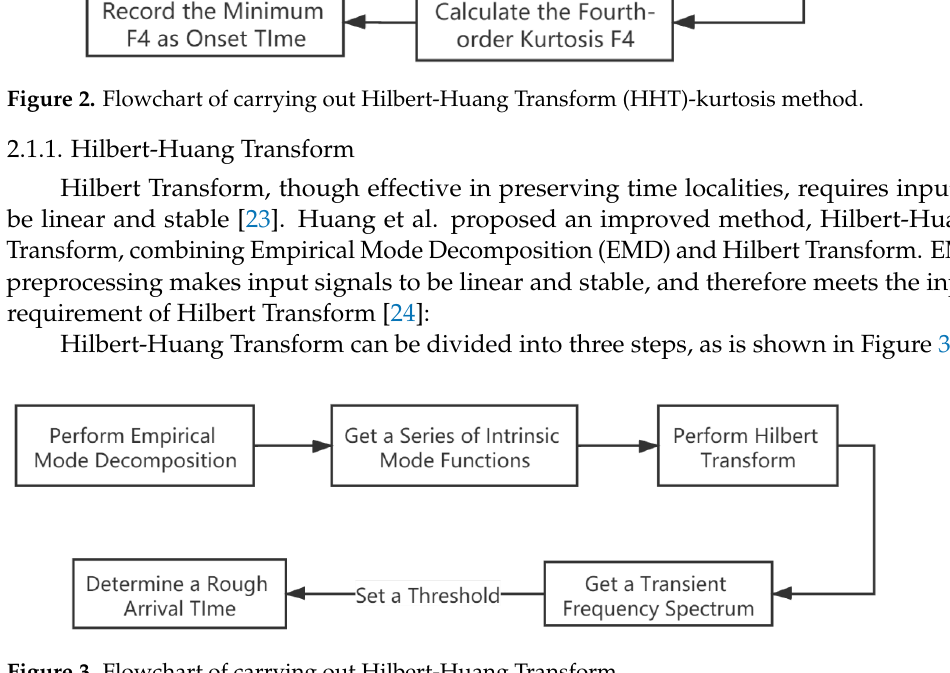
Figure 3. Flowchart of carrying out Hilbert-Huang Transform.